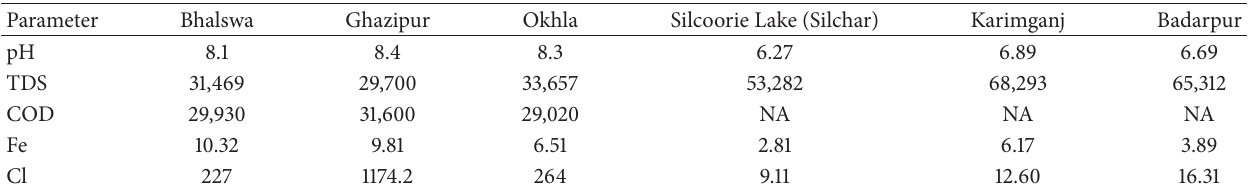
Table 2: Chemical analysis of leachate samples obtained from three landfill and marshland sites. All parameters are in mg L −1 adapted from Ghosh et al. 2015 and Roy and Gupta 2012 [37, 38].